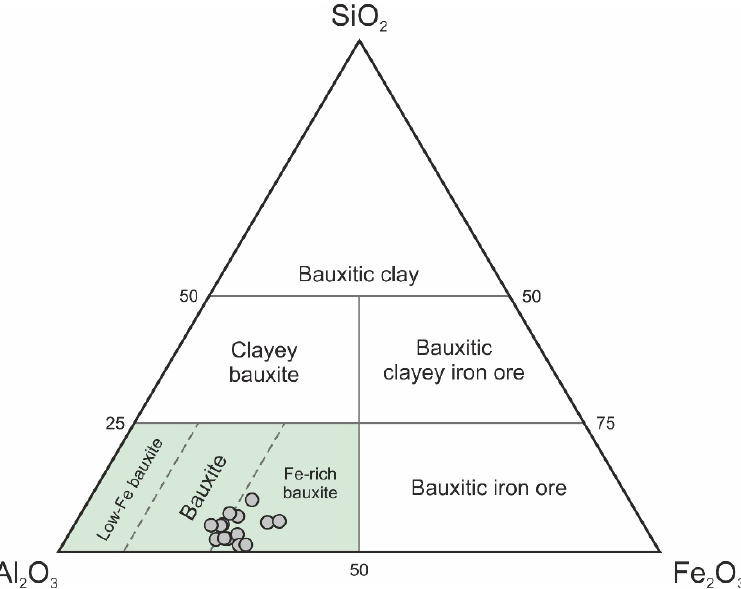
Figure 5. Al 2 O 3 –SiO 2 –Fe 2 O 3 classification diagram (modified from Bárdossy, [5]) for the SGR deposit. Grey circles are samples from the studied bauxite.